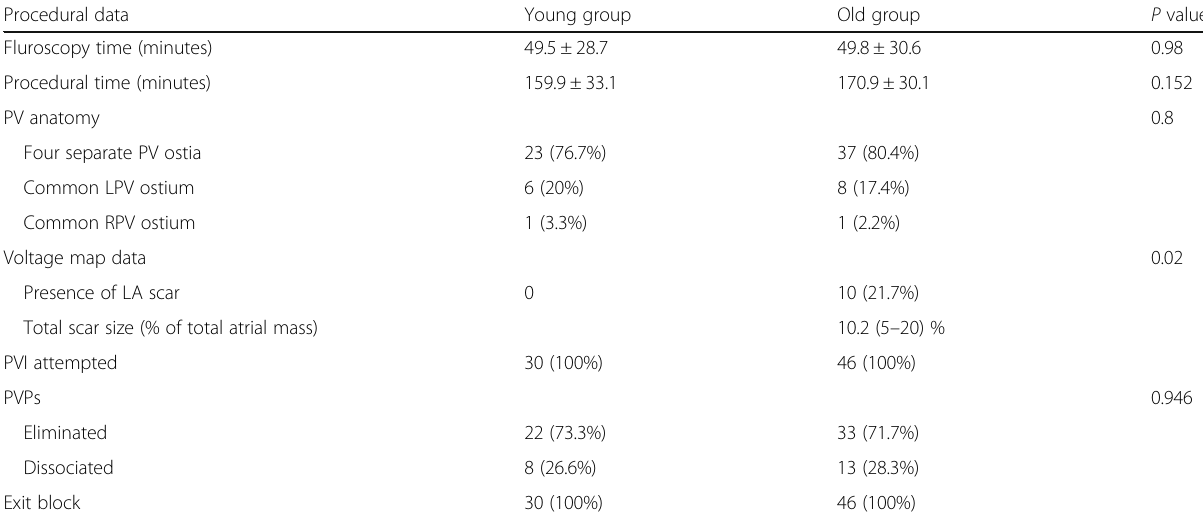
Table 2 Procedural data of AF ablation in both study groups Procedural